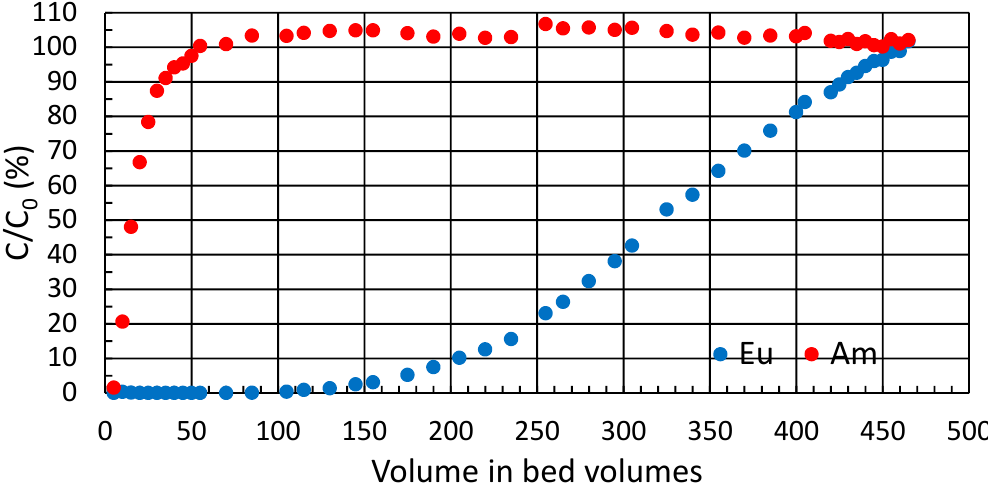
Figure 6. Constant feed low-pressure column binary separation experiment for Eu(III) and Am(III) for ZrP. Constant equimolar feed of 1 nmol · L − 1 of each element in 0.1 M HNO 3 with 0.1 M NaNO 3 . The bed volume is 1.0 mL, feed rate is 5.0 BV · h − 1 , and mass of the exchanger is 443 mg.